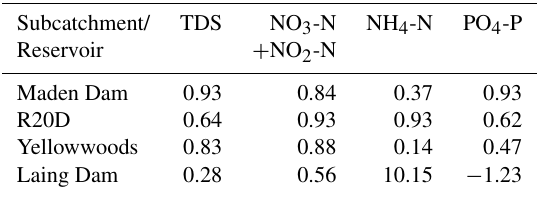
Table 1. Nash-Sutcliffe Efficiency (NSE) (Nash and Sutcliffe, 1970) values calculated for the Water Quality Systems Assessment Model (WQSAM) (Slaughter et al., 2012) simulations compared against historical observed data for various water quality variables for various subcatchments/reservoirs of the Buffalo River catch-